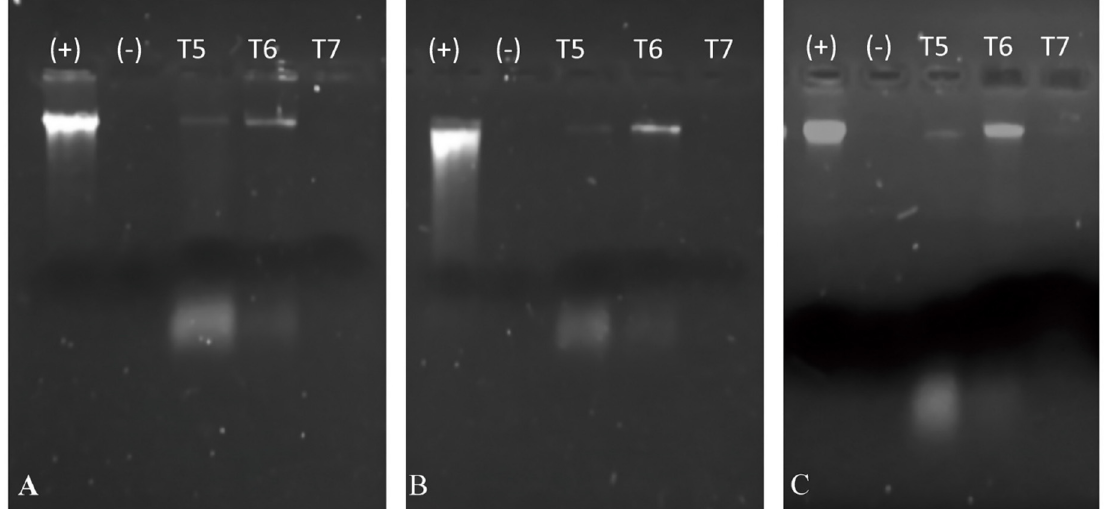
Figure 6. Leakage of DNA/RNA molecules from: upon the treatment with the antimicrobial cocktails. Legend: (+) genomic DNA of E. coli ATCC25922 ( A ), Salmonella enterica ATCC51741 ( B ), Shigella sonnei ATCC25931 ( C ) (-) negative control (no antimicrobial tested); T5: (Cys5-4+ Gt28)PP: 1:3 ( v/v ); T6: (Cys5-4+ Gt28)PP: 3:1 ( v/v ); T7: nisin (Sigma-Aldrich, USA).